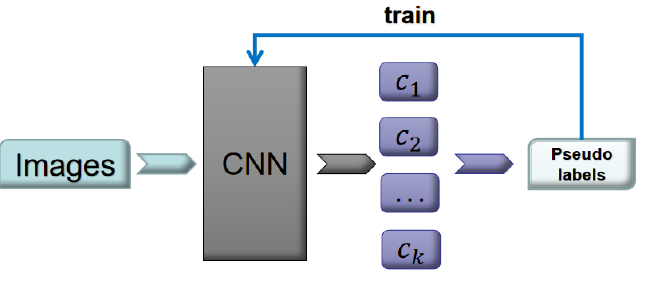
Figure 1. Schematics of representation learning based on clustering: input images are clustered into k clusters according to representations (or outputs) extracted from the CNN; and then the identities of clusters are utilized as pseudo-labels to train the